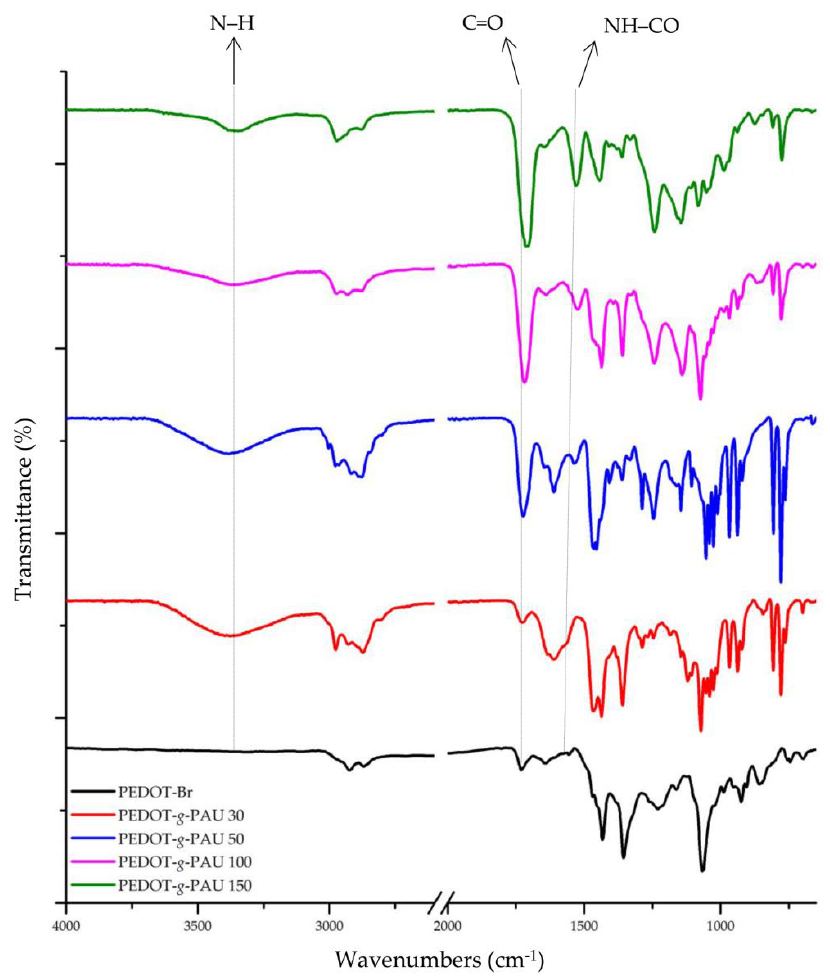
Figure 2. FTIR spectra of PEDOT-Br macroinitiator and PEDOT- g -PAU copolymers.